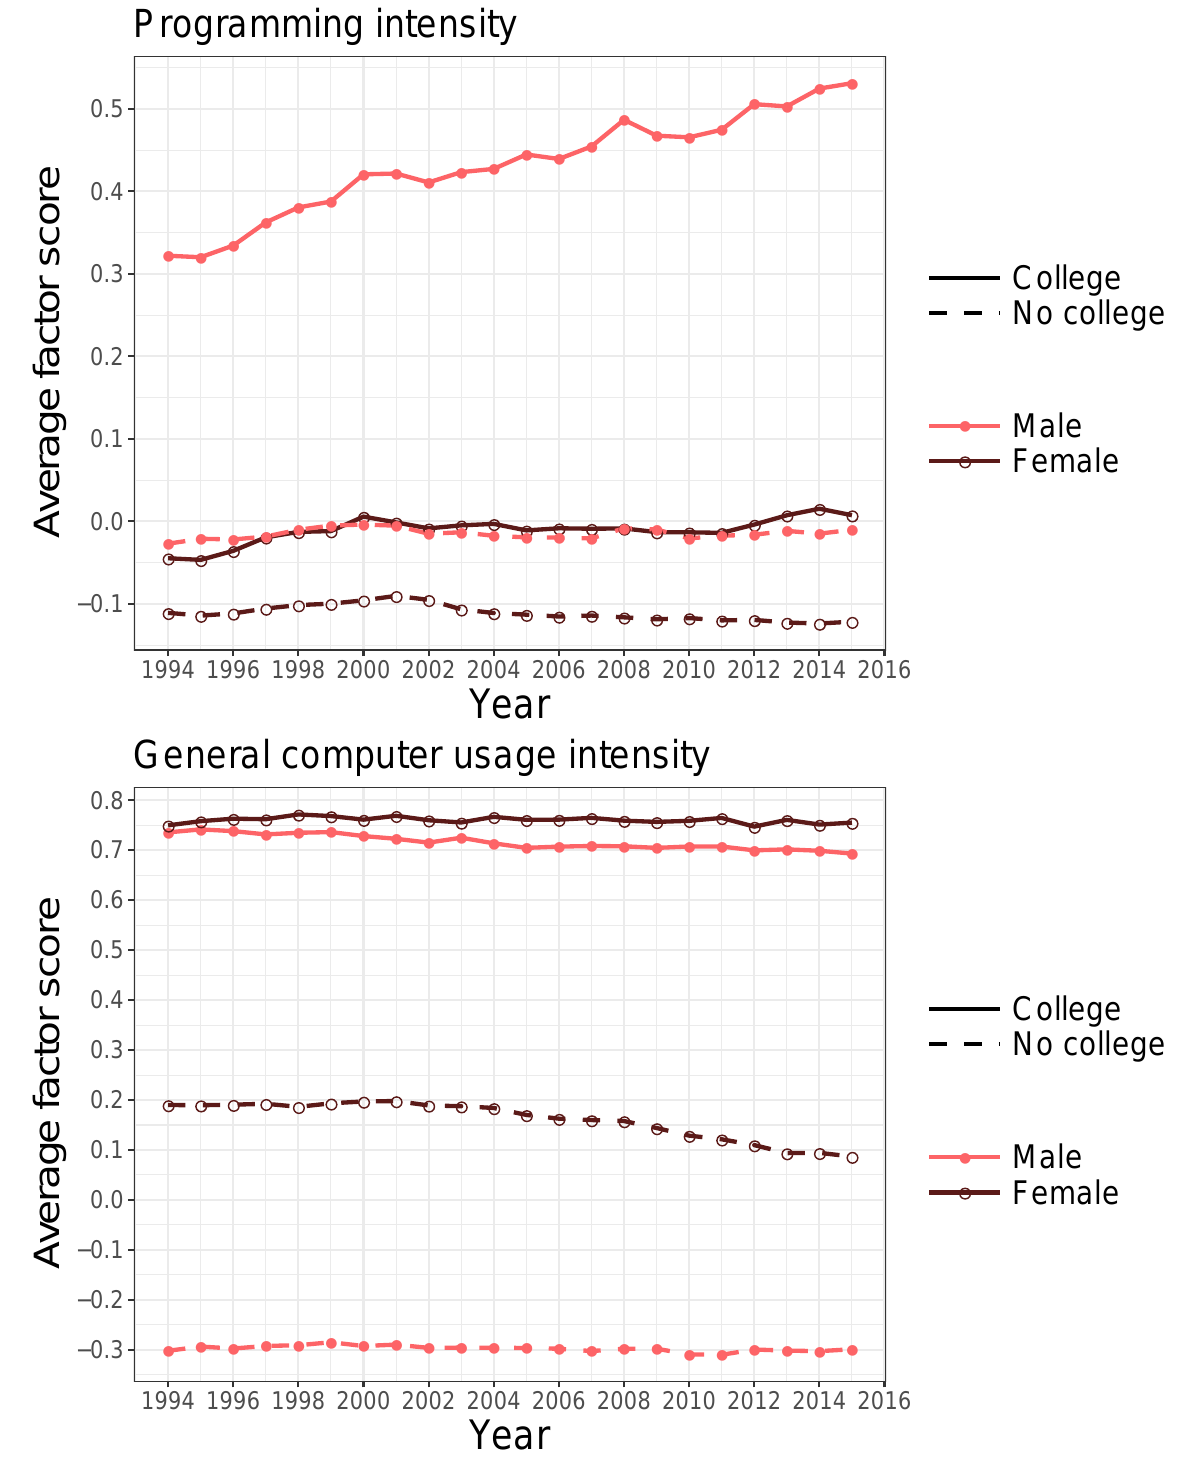
Figure 2: Gender-specific trends in average factor scores of programming intensity and general computer usage intensity. See Figure 1 for the data